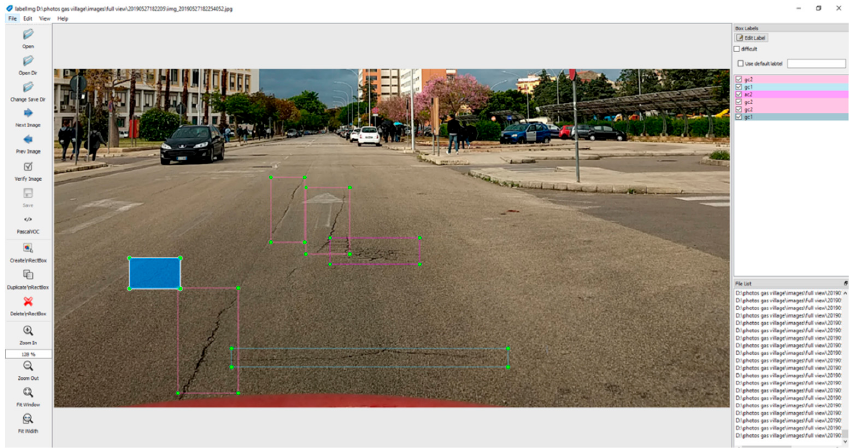
Figure 5. Annotation of images using LabelImg.